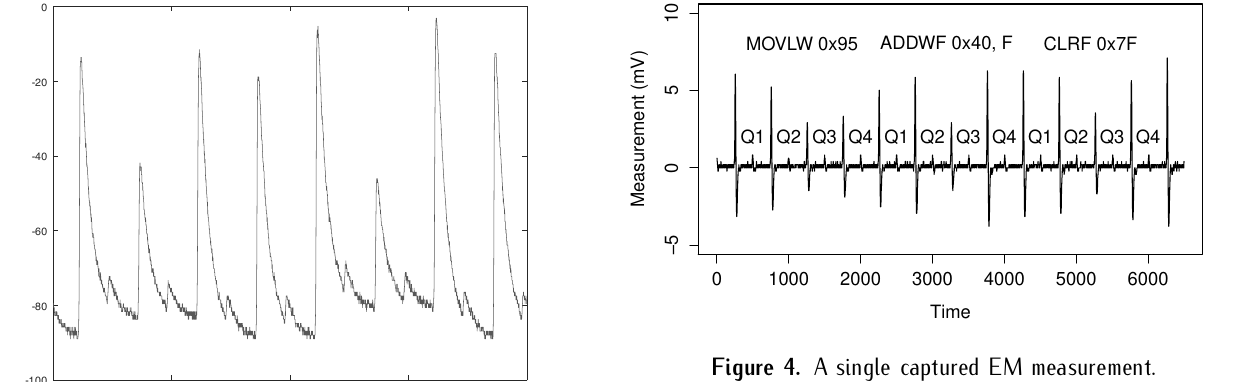
Figure 4. A single captured EM